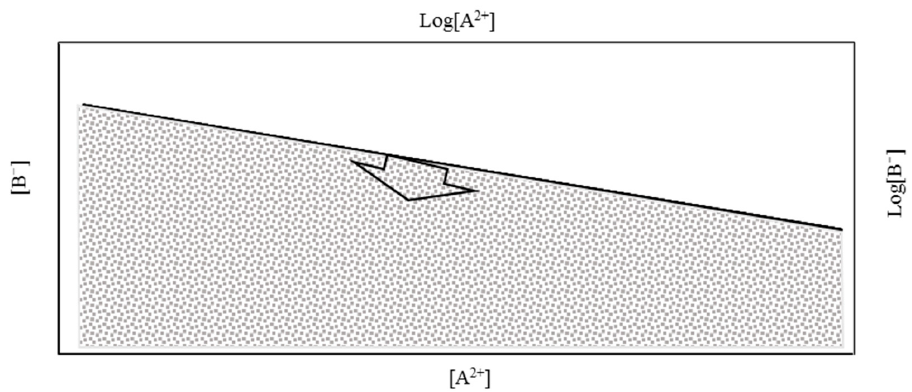
Figure 1. Solubility of a hypothetic mineral AB 2 . The grey area represents non ‐ saturated conditions and the area above the line represents super ‐ saturated conditions. The line dividing these two areas is the saturation